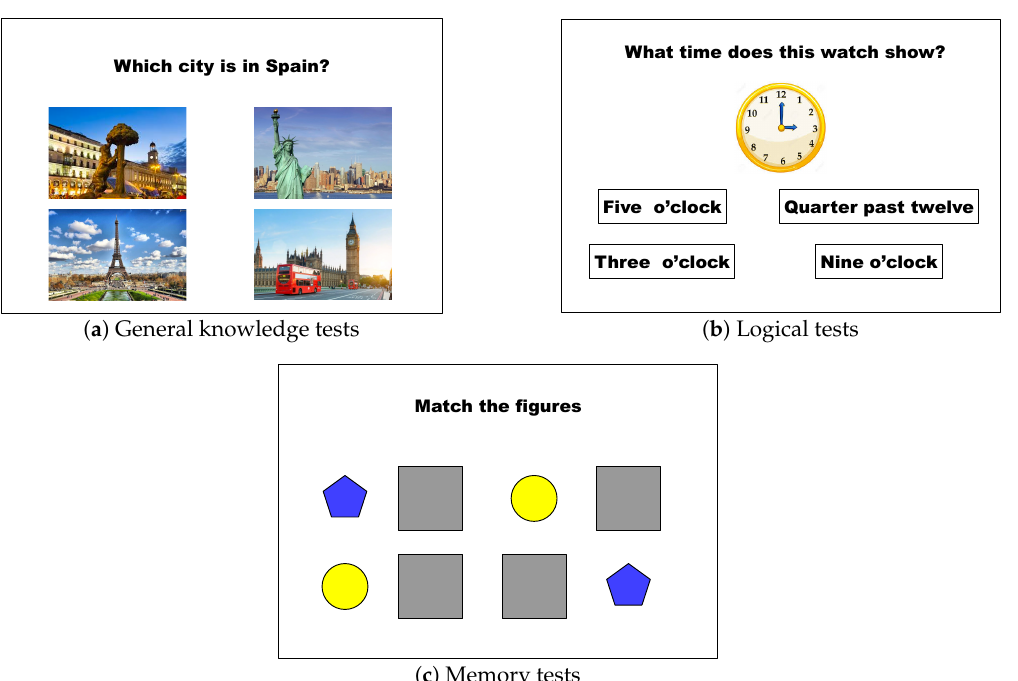
Figure 3. Games that are part of cognitive therapy. ( a ): General knowledge game; ( b ): Logical game; ( c ): Memory